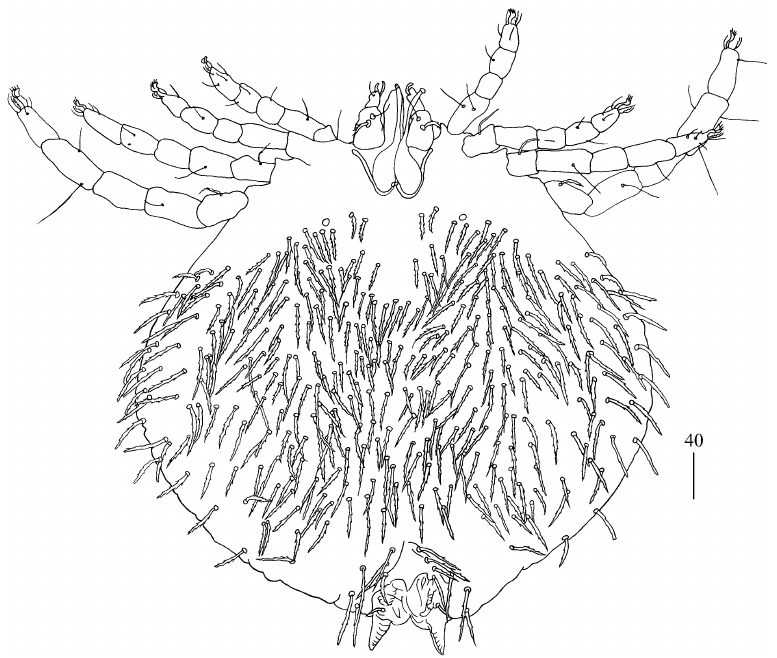
Figure 6. Geckobia mysoriensis sp. n. female in dorsal view.